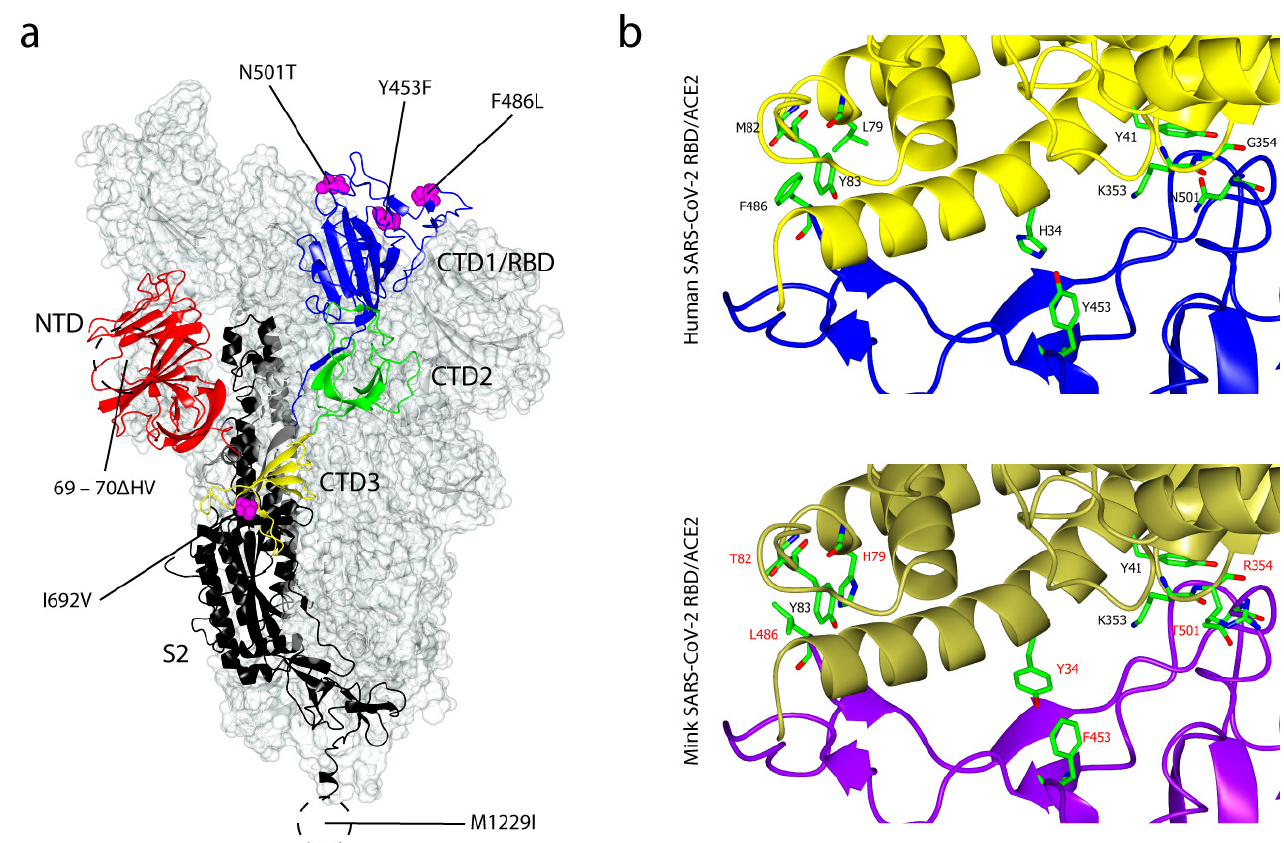
Figure 3. Mink-derived Cluster 5 of SARS-CoV-2 S glycoprotein mutations and their impact on the ACE2 interface. ( a ) The location of a deletion and five substitution mutations on the cryoelectron microscopy structure of the mink-derived SARS-CoV-2 S glycoprotein at 2.83 Å (PDB: 7LWM). Three mutations, Y453F, F486L and N501T, lie within the RBD (CTD1) of the SARS-CoV-2 S protein, the deletion mutation 69–70 ∆ HV is in the NTD, I692V is in the CTD3 and M1229I is in the hydrophobic region of the SARS-CoV-2 S glycoprotein. ( b ) A comparison between human SARS-CoV-2 RBD/ACE2 (top) and mink SARS-CoV-2 RBD/ACE2 (bottom). In humans, residues that are important in the ACE2 (yellow) binding are F486, Y453 and N501 within the SARS-CoV-2 RBD (blue). These residues are replaced by Leu, Phe and Thr, respectively in mink SARS-CoV-2 RBD (purple). H79, T82 and Y83 of the mink ACE2 (gold) interact with L486, Y34 interacts with F453, Y41, K353 and R354 interact with T501. As the mink SARS-CoV-2 RBD/ACE2 structure has not been determined, the human SARS-CoV-2 RBD/ACE2 structure (PDB: 6M0J) [41] was used for reference and modelling was performed using PyMol.